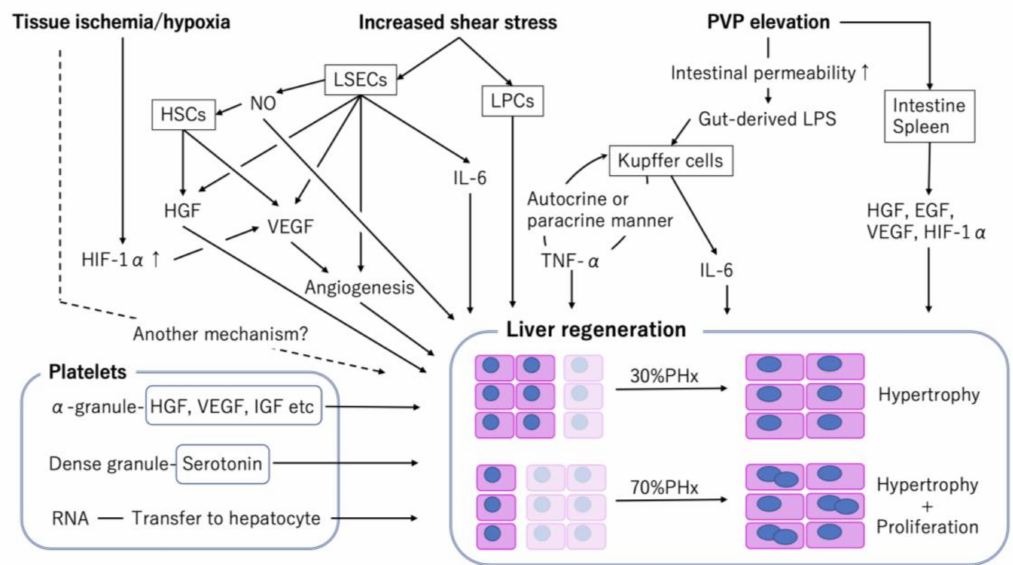
Figure 1. Factors associated with liver regeneration after partial hepatectomy (PHx) and partial liver transplantation (PLTx).Various factors are associated with liver regeneration after PHx and PLTx; moreover, the mode of regeneration is influenced by the amount of liver resection [4]. EGF, epidermal growth factor; HGF, hepatocyte growth factor; HIF-1 α , hypoxia inducible factor 1-alpha; HSCs, hepatic stellate cells; IGF, insulin-like growth factor; IL, interleukin; LSECs, liver sinusoidal endothelial cells; LPCs, liver progenitor cells; LPS, lipopolysaccharide; NO, nitric oxide; PVP, portal vein pressure; TNF, tumor necrosis factor; VEGF, vascular endothelial growth